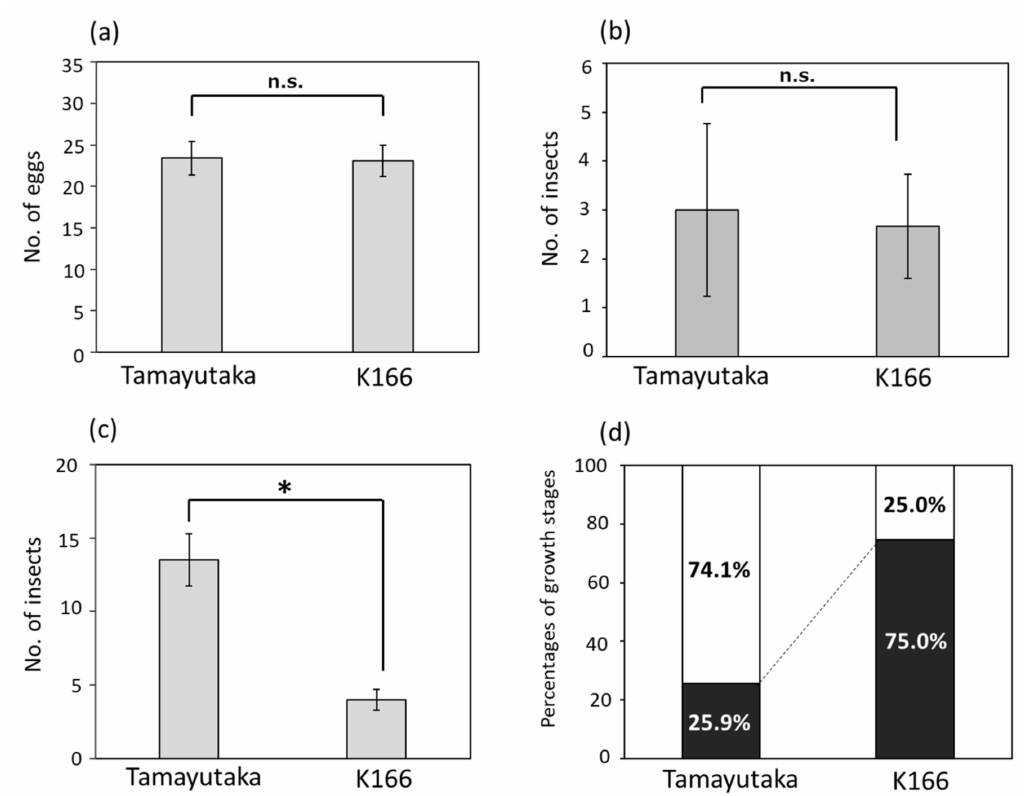
Figure 1. Results of the weevil resistance tests between the susceptible Tamayutaka and resistant Kyushu No. 166 (K166) cultivars. ( a ) The average number of eggs per tuberous root at 3 days after inoculation; ( b ) the average number of insects per tuberous root at 15 days after inoculation; ( c ) the average number of insects at 30 days after inoculation; ( d ) the growth state of insects at 30 days after inoculation. Black and white bars indicate the ratios of the larvae and pupae, respectively. * p < 0.05, n.s.: not